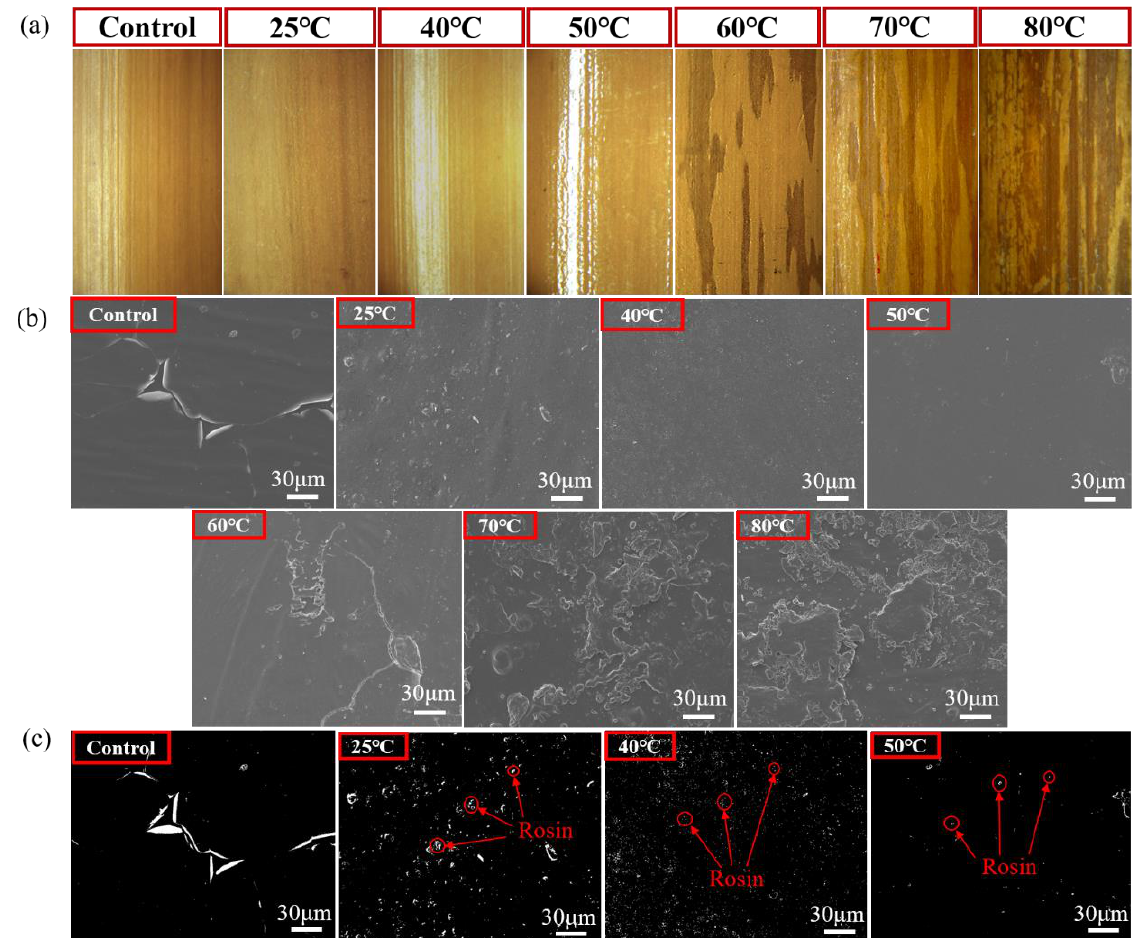
Figure 4. ( a ) Surface texture of bamboo culm observed using stereomicroscopy; ( b ) the surface micromorphology of bamboo culm observed using FE-SEM; ( c ) the surface micromorphology after thresholding by FIJI/Image J software.